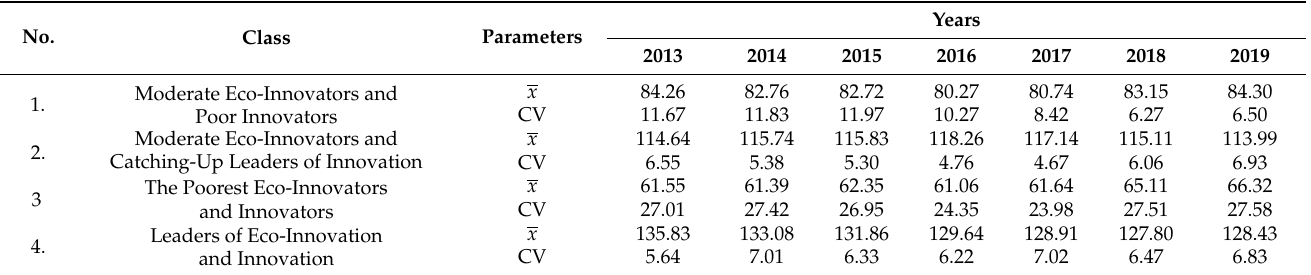
Table 6. Descriptive parameters of the Summary Innovation Index value for the selected types of classes of the European Union countries in the years 2013–2019 (EU average =